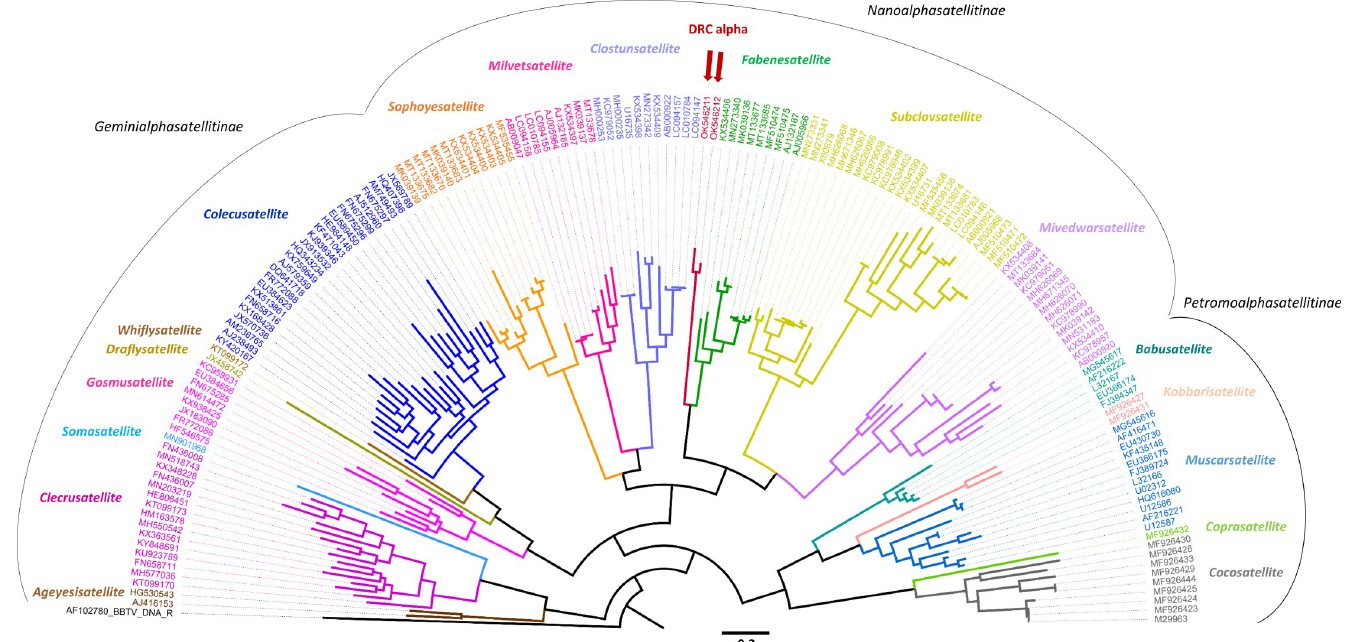
Fig 1. Phylogenetic analysis of DRC alphasatellite. A maximum likelihood phylogenetic tree of complete nucleotide sequences of the two isolates of DRC alphasatellite and all isolates of other alphasatellites associated with helper viruses of the families Nanoviridae , Metaxiviridae and Geminiviridae is rooted with BBTV DNA-R. The Genbank accession number is given for each alphasatellite. Alphasatellites’ genera are color-coded and their subfamilies delineated. Position of the DRC alphasatellite’s genus ( Banaphisatellite ) is indicated with red arrow. Note that the subfamily Petromoalphasatellitinae comprises all previously-identified BBTV alphasatellites representing 3 species, namely, BBTA1 (L32167, [31,32];AF216222, [35]; FJ394347, [37]; MG545617, [39]; EU366174, Genbank only), BBTA2 (AF416471, [34]; EU430730, [36]; MG545616, [39]) and BBTA3 (L32166, [31,32];U02312, [33]; AF216221, [35]; HQ616080, [38]; FJ389724, [37]; EU366175, U12586 and U12587, Genbank only), and alphasatellites of cardamom bushy dwarf virus (CBDA: KF435148; [72]) and coconut foliar decay virus (CFDA1: M29963, MF926423, MF926424, MF926425; CFDA2: MF926426; CFDA3: MF926427, MF926431; CFDA4: MF926429, MF926444, MF926433; CFDA5: MF926430; CFDA7: MF926432; [89]), which belong to the genera Babusatellite (BBTA1), Muscarsatellite (BBTA2, BBTA3, CBDA), Cocosatellite (CFDA1, CFDA2, CFDA4, CFDA5), Coprasatellite (CFDA7) and Kobbarisatellite (CFDA3). The genus Fabenesatellite of subfamily Nanoalphasatellitinae , the closest to BBTV DRC allphasatellite’s genus, comprises variants of faba been necrotic yellows alphasatellite 2 associated with faba bean necrotic yellows virus (AJ005966, AJ132187, MF510474, MF510475; [66,68]), sophora alopecuroides yellow stunt virus (KX534406; [67]), milk vetch chlorotic dwarf virus (MN273330 = MN273340; [70]) and parsley severe stunt-associated virus (MK039136, MT133677, MT133685; [69,71]).